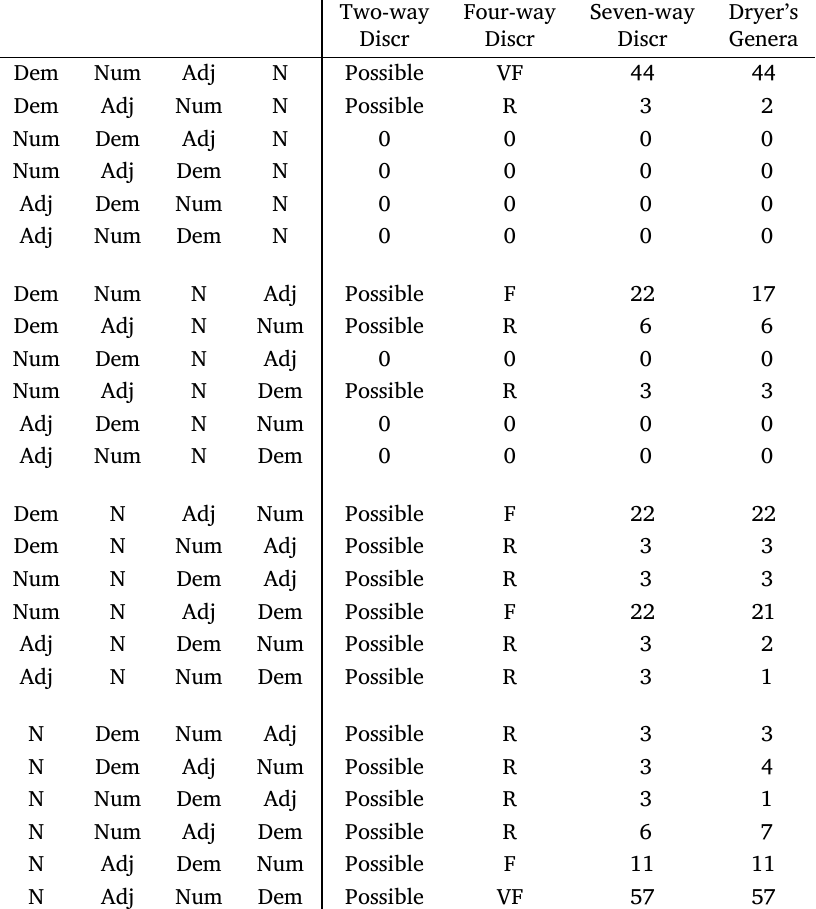
Table 2: Two-way (possible or 0), four-way (very frequent, frequent, rare, none, abbreviated as VF,F,R,0) and seven-way (57,44,22,11,6,3,0) discretisation and the observed counts based on genera from